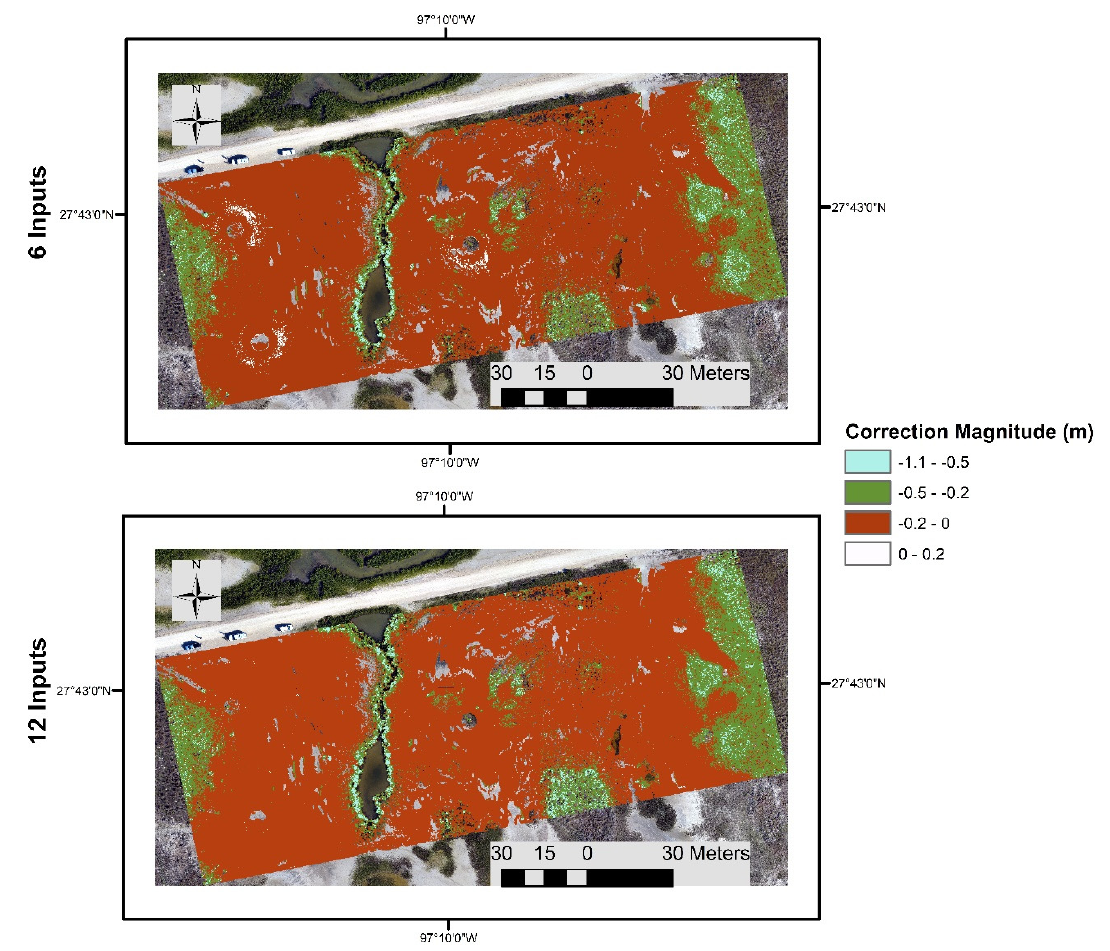
Figure 8. Magnitudes of ENN corrections of 6 ( top ) and 12 inputs ( bottom ) for the 47th selected run from Section 4.1. Magnitudes are computed as the difference in elevation between the uncorrected DEM and corrected DEM (i.e., uncorrected DEM–corrected DEM) at each respective grid cell location.